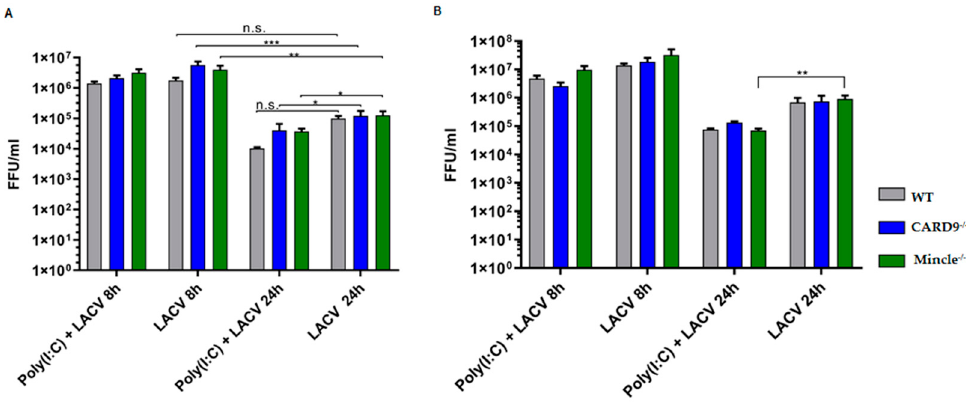
Figure 6. Viral loads in Mincle − / − , CARD9 − / − , and WT DCs challenged with LACV. Virus titer in the supernatant of Mincle − / − , CARD9 − / − and WT DCs infected with LACV at a MOI 5 ( A ) and a MOI 20 ( B ) for 8 h and 24 h. Data shown are mean ± SEM of three independent experiments. A two-way ANOVA with a Tukey’s honest significance test was employed and p < 0.05 was considered significant (* p < 0.05, ** p < 0.01, *** p < 0.001).